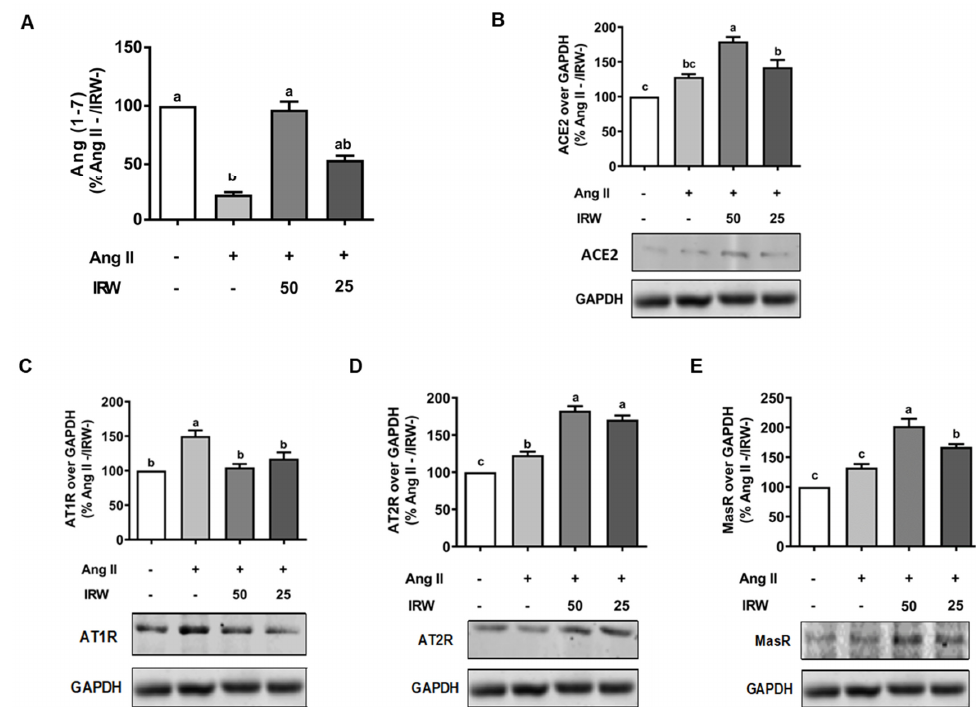
Figure 3. The effect of IRW on regulating RAAS signaling with Ang II stimulation. Osteoblast cells MC3T3-E1 were pre-treated with IRW (50 μ M and 25 μ M) for 2 h prior to Ang II (1 μ M) and then co-cultured for 24 h. Whole cell lysates were collected and used for the ELISA and Western blotting analysis. ( A ) The RIPA buffer extracts were used for measuring Ang (1–7) levels using ELISA and the protein expression of ( B ) angiotensin-converting enzyme 2 (ACE II), ( C ) angiotensin II receptor type 1 (AT1R), ( D ) angiotensin II receptor type 2 (AT2R), and ( E ) Mas receptor (MasR) were meas- ured using Western blot. All results are representative of 6 independent experiments and expressed as mean ± SEM. Mean without a common letter indicated p < 0.05. 3.4. IRW Mitigates Inflammation Induced by Ang II Stress in Bone Cells As inflammation skews the process of coupling towards bone resorption [33], its in- hibition can play important role in the restoration of bone health. Our results showed that Ang II (1 μ M) triggered a strong increase in inflammatory markers including COX2 and NF- κ B (Figure 4A,B). This increase in both biomarkers was attenuated back to the basal levels following treatment with IRW (50 μ M and 25 μ M) in MC3T3-E1 cells ( p < 0.05) (Fig- ure 4A,B). These results support the earlier findings of cytoprotection by IRW in MC3T3- E1 cells (Figure 1).